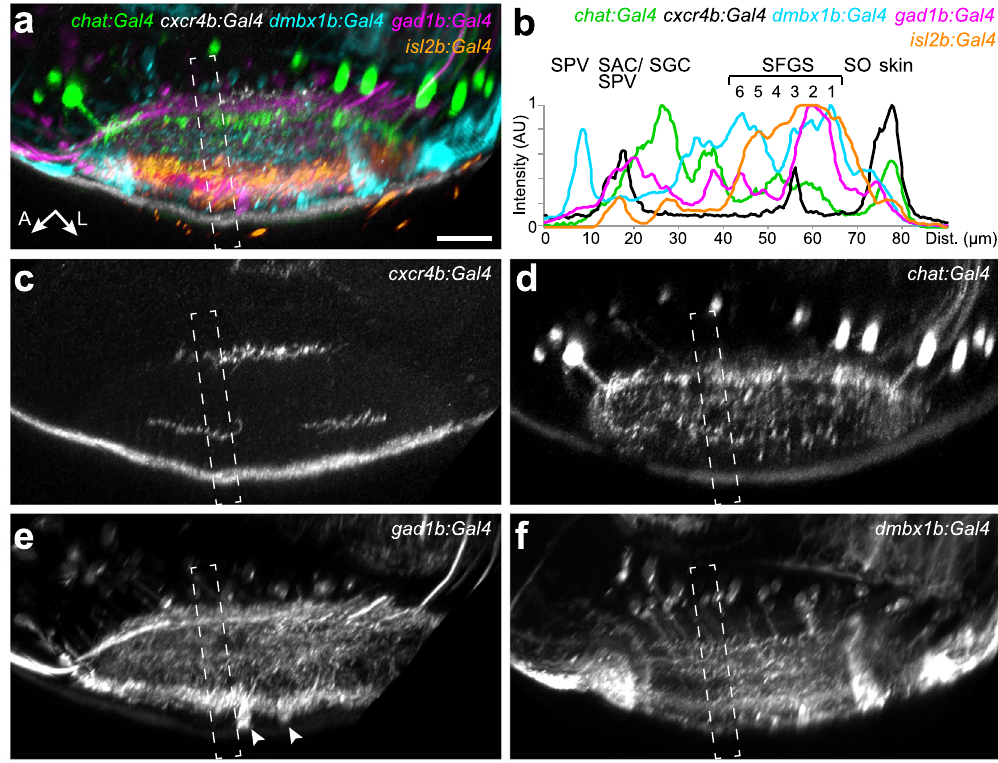
Figure 5. New transgenic lines label distinct sublaminae in the tectal neuropil. Lateral view of the tectal neuropil shows registered expression pattern of chat:Gal4 , cxcr4b:Gal4 , dmbx1b:Gal4 , gad1b:Gal4 , and isl2b:Gal4 , as merged ( a ) or single channels ( c – f ). ( b ) Fluorescence intensity plots along the boxed regions in ( a – f ). Intensity peaks of isl2b:Gal4 expression were used for layer determination. SIN cell bodies labeled by gad1b:Gal4 are marked by arrowheads in ( e ). The peak for dmbx1b:Gal4 in the SPV layer reflects labeled periventricular cell